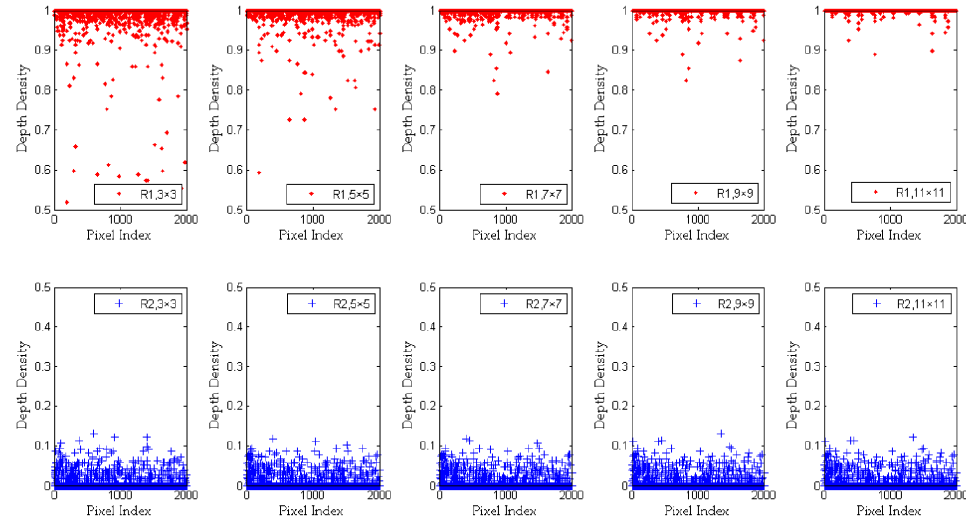
Figure 6. The depth density of all pixels in R1 and R2 by Equation (14). We set the size s to 3 × 3, 5 × 5, 7 × 7, 9 × 9, and 11 × 11, respectively. The depth density range of R1 is [0, 1]. The depth density range of R2 is [0, 0.5]. The pixel index represents the total number of pixels obtained by R1 or R2.